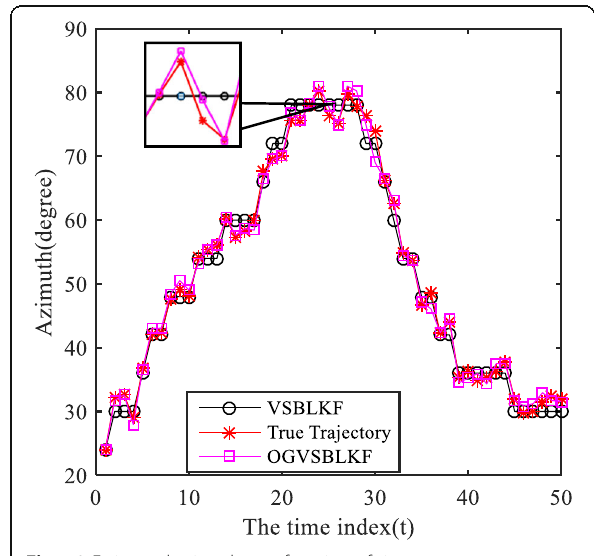
Fig. 10 Traces of two proposed methods in the off-grid model